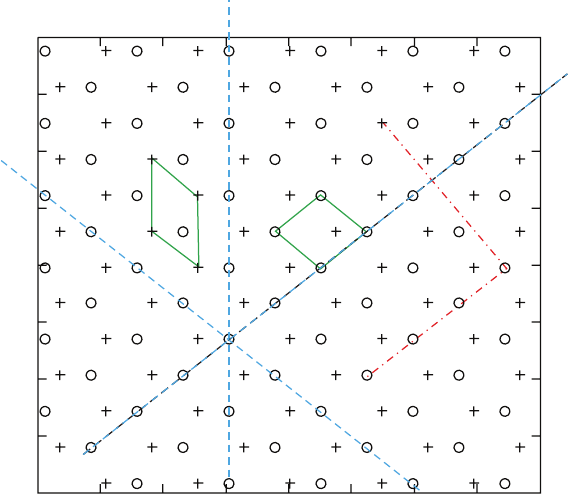
Figure 5: The vortex lattice consists of two sublattices which are marked by plus signs and circles. The CALs of wave pairs A and B , B and C , A and C are marked by dashed blue lines and are parallel to the corresponding A + B , B + C , and A + C fringe systems. Figure shows an example of two cells, whose sides are determined by CALs and one triplet (red dashed-dot line). The vortex cells must be occupied by the vortex points having the same topological charge, while the triplets can be composed of any three vortex points, which are not